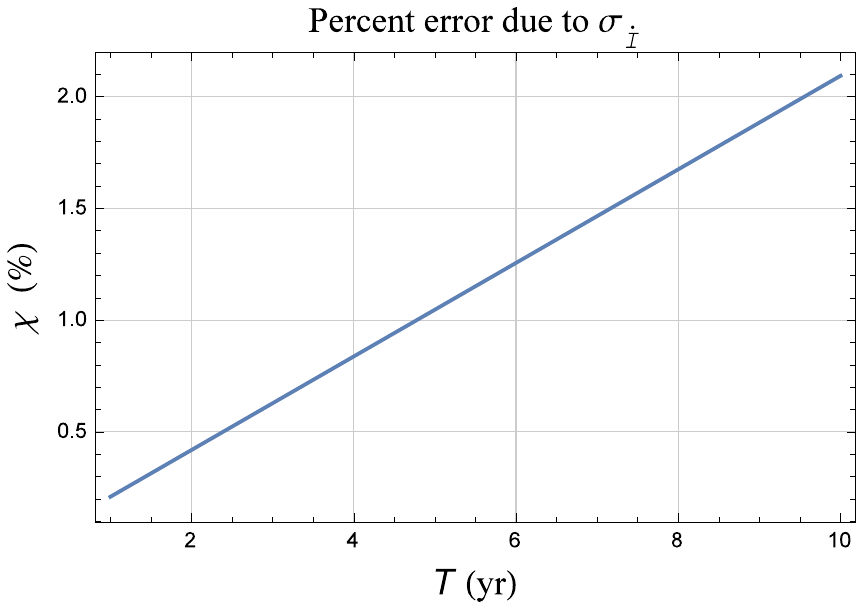
Figure A7. Percent systematic error χ in the total L + CL Lense–Thirring node shift due to the uncertainties in the presumed secular decay of the inclinations of L and CL calculated as a function of the data analysis time span T with Equation (32) into Equation (51). For CL, we assumed ∆ a CL = 10 km, ∆ I CL = 0.15 deg, ˙ I L = − 0.7 mas yr − 1 , ˙ I CL = − 0.4 mas yr − 1 , σ ˙ raising σ ˙ up to, say, 0.2 mas yr − 1 would bring χ to about 14% after 10 I